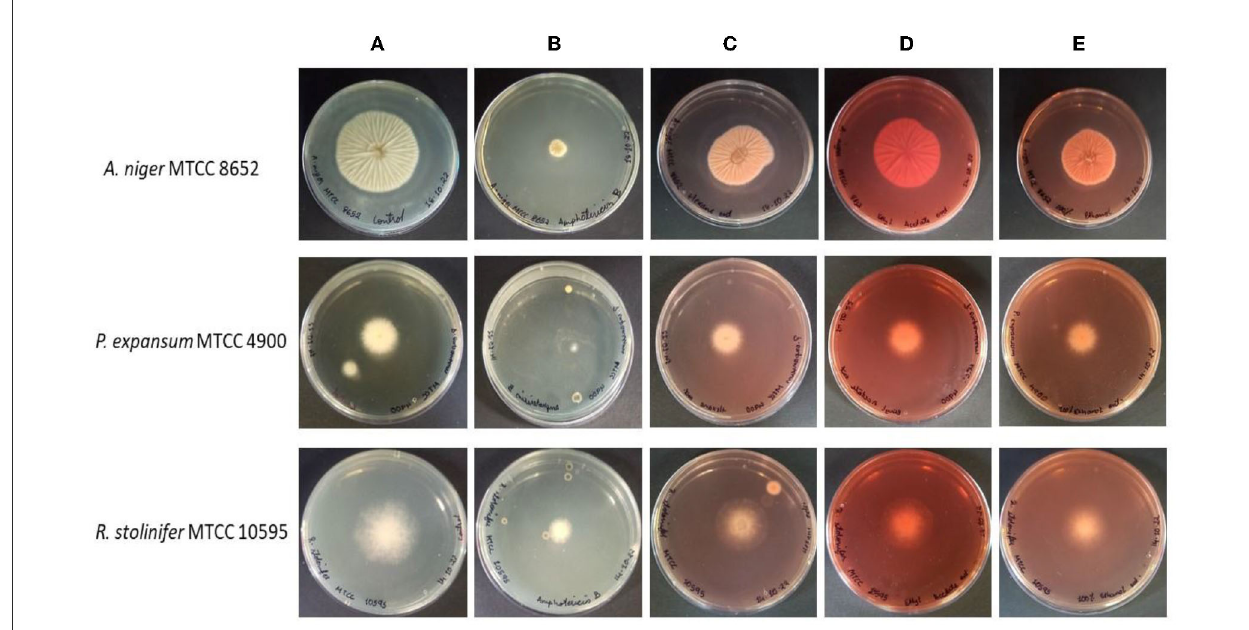
FIGURE1 Antifungal activity of M. purpureus pigment extracts [hexane (C) , ethyl acetate (D) , and ethanol (E) ] against the A. niger MTCC 8652, P. expansum MTCC 4900, and R. stolinifer MTCC 10595, as determined by hyphal radial growth inhibition after 4–5 days of incubation at 30 ◦ C. The PDA plate without any treatment serves as control (A) and the PDA plate containing amphotericin-B served as a positive control (B)